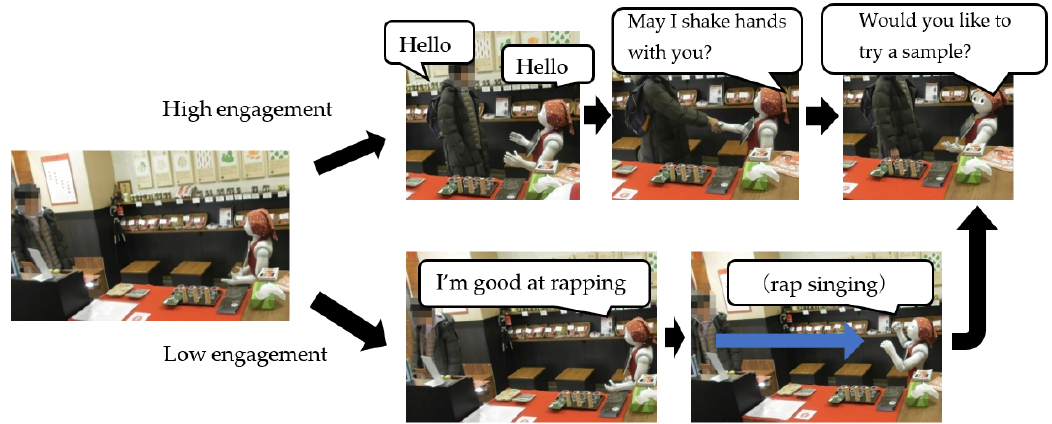
Figure 14. Part of the state transition based on the interaction between the customers and robot.